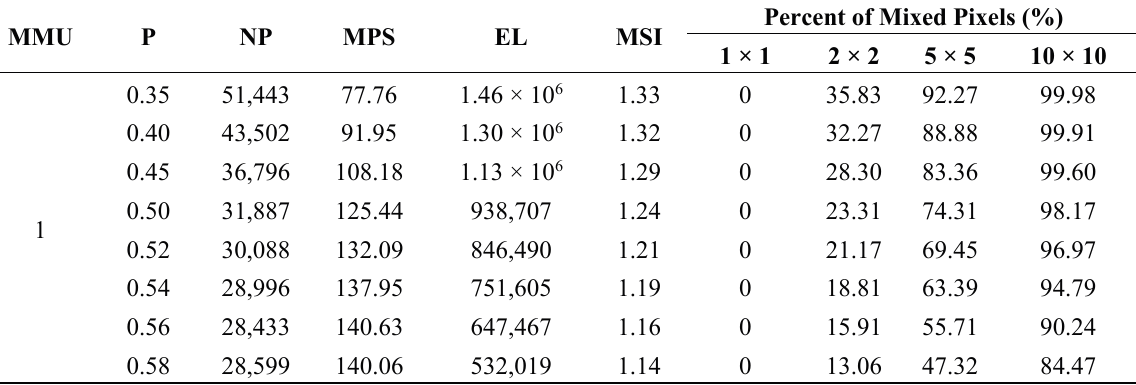
Figure 1. Selectively simulated landscapes (thematic maps) with P being 0.35, 0.54 and 0.58 respectively and MMU being 1, 10 and 99 respectively. Table 1. The spatial characteristics of the simulated hard categorical maps and the percent of mixed pixels after aggregation using different